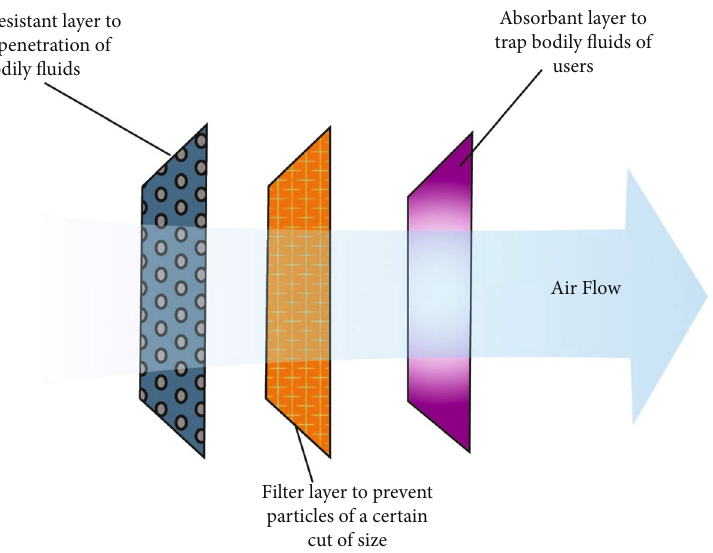
Figure 2: Schematic diagram for functions of di ff erent layers of 3-ply surgical face